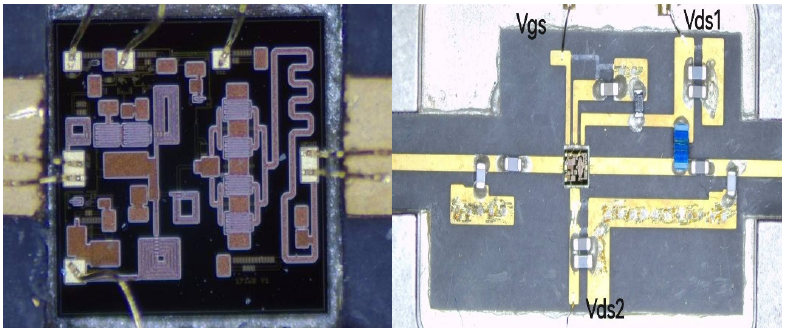
Figure 6. The photograph and experiment fixture of MMIC PA.